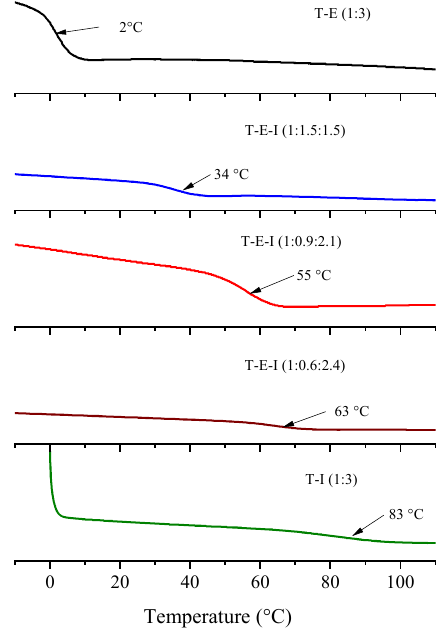
Figure 5. Comparison of the T g of the obtained polyHIPEs.